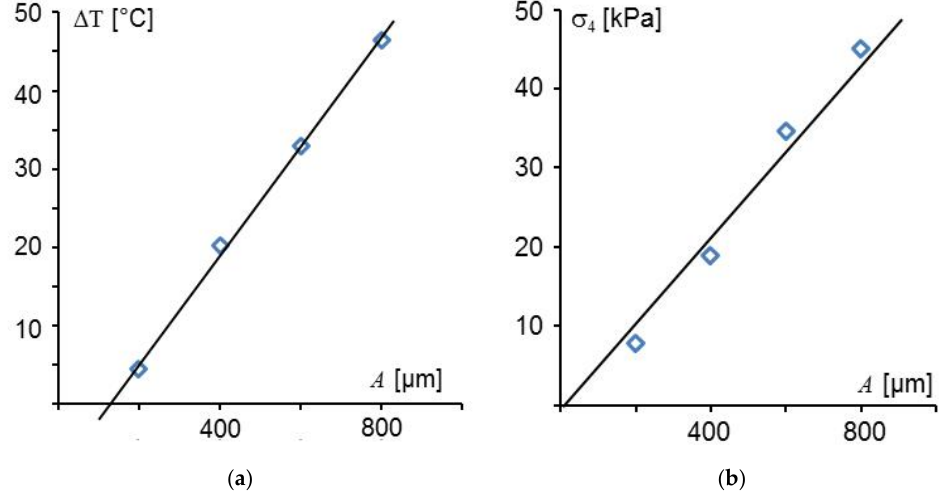
Figure 16. Temperature rise Δ T ( a ) and shear stress σ 4 ( b ) as a function of the amplitude A of the linear vibrations of the friction welding